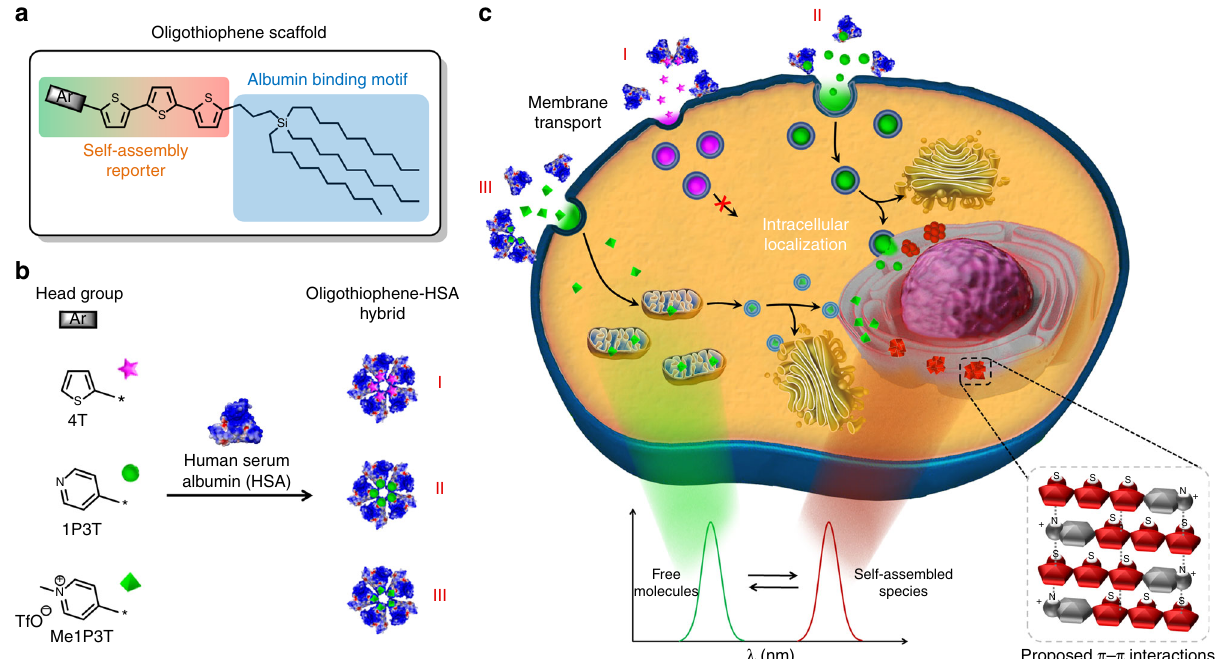
Fig. 2 Controlling intracellular assemblies. a Oligothiophene design containing a self-assembly reporter and an albumin binding motif. b Formation of stable complexes (I – III) with human serum albumin (HSA) that mediates water-solubility and cellular uptake. c Each oligothiophene analogue localizes and self- assembles intracellularly in a unique way based on the tailored aromatic head group (Ar), which allows real-time detection of molecular (green fl uorescence) and self-assembled (red fl uorescence) states. Several intracellular compartments can be speci fi cally targeted by simply adjusting the head group (Ar) of the